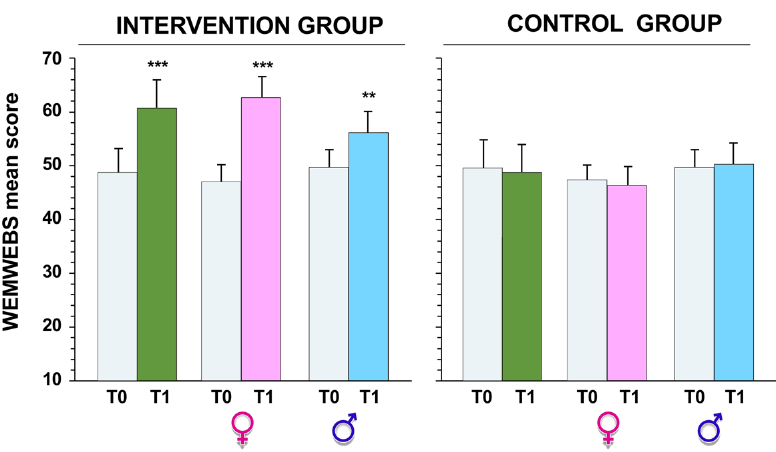
Figure 5. Warwick – Edinburgh mental well-being scale (WEMWBS) score obtained before (T0) and after (T1) intervention, in both the intervention and control groups. ** p < 0.01 and *** p < 0.001 by paired Student ’ s t test.